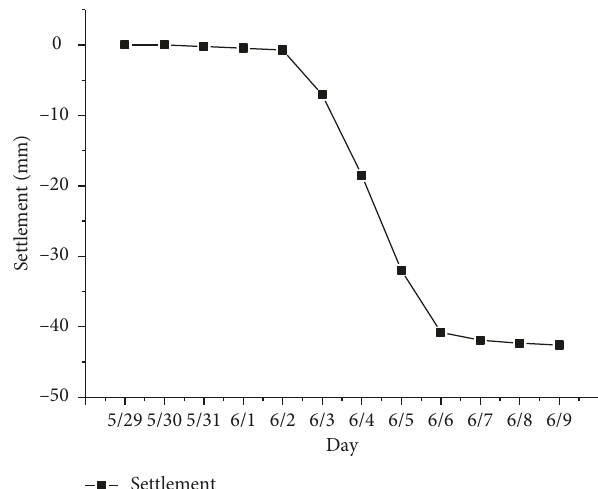
Figure 2: Settlement data of DB10550-5 at mile 10–550 monitoring